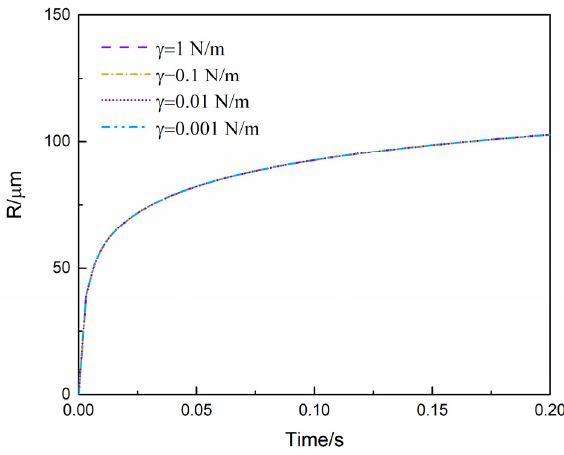
Figure 9. Effect of surface tension ( γ ) on predicted bubble growth